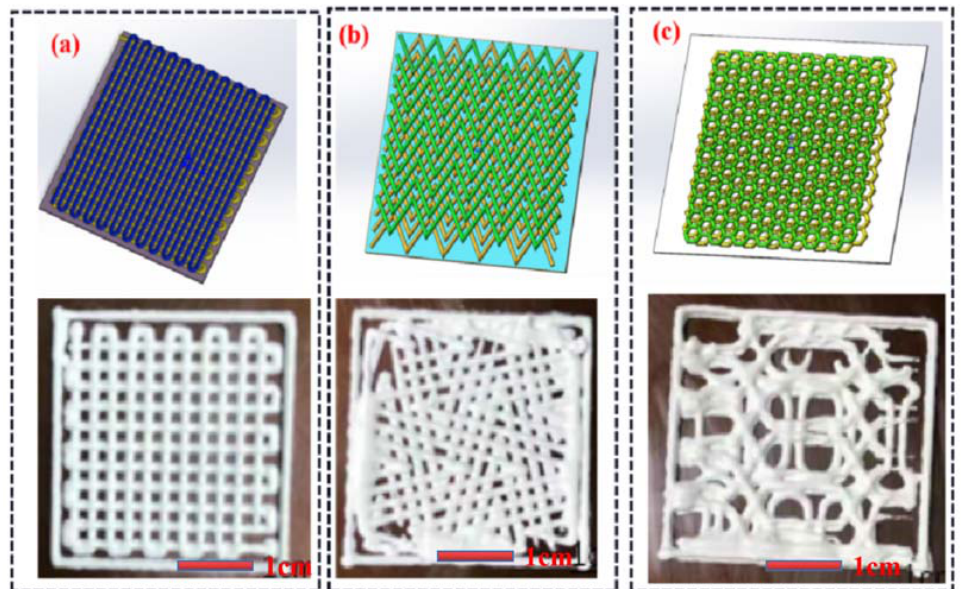
Figure 10. Different internal structures model and printed samples: ( a ) linear schematic; ( b ) bending line schematic; ( c ) honeycomb. line schematic; ( c ) honeycomb.